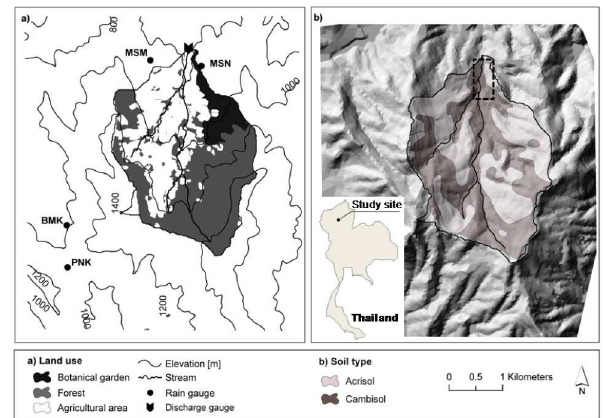
Fig. 1. Mae Sa Noi sub-catchment with (a) measurement devices (MSM, MSN, BMK, and PNK), land use in 2008 (modified after M. Lippe, SFB 564, Subproject C4.1) and (b) sampling area (black square), topography, and soil types (modified after Schuler et al., 2008).